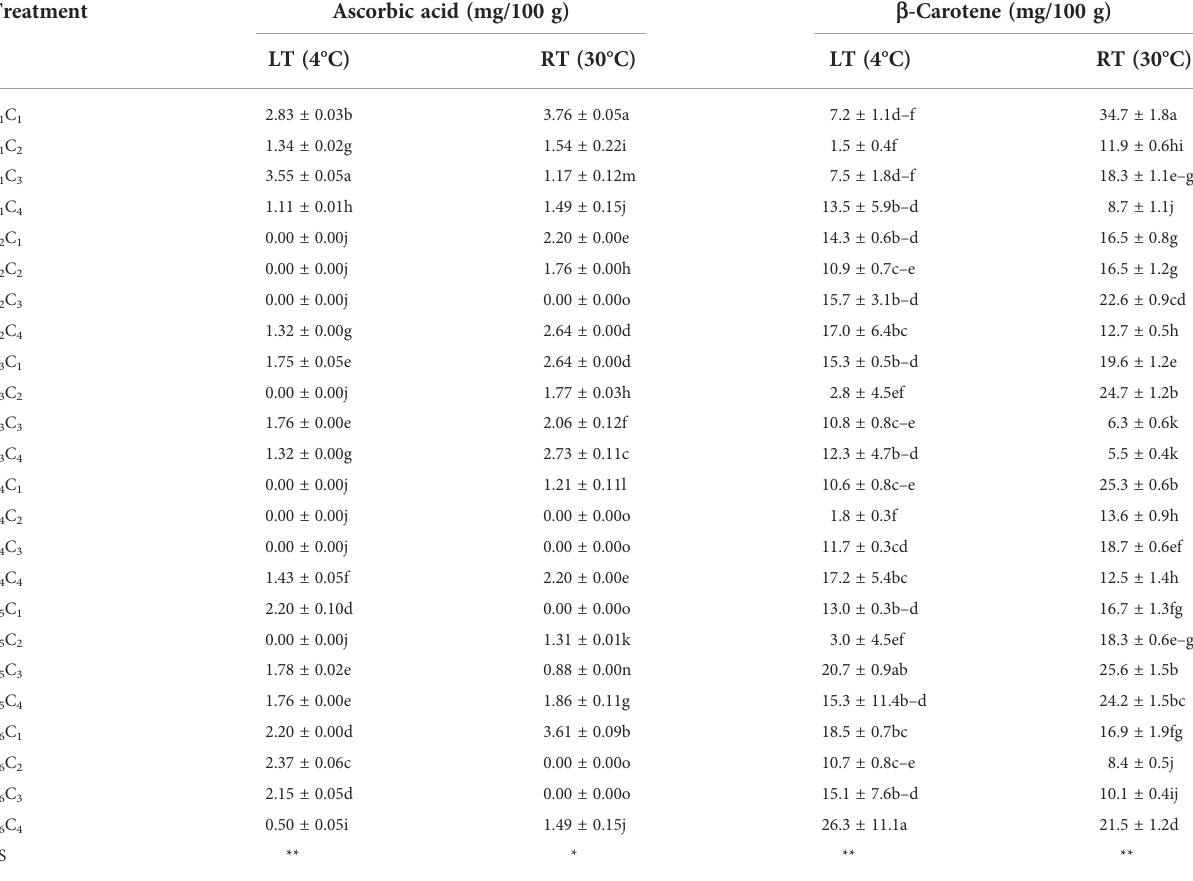
TABLE 4 Nutritional qualities of pointed gourd up to acceptance level under different postharvest treatment and packaging conditions.